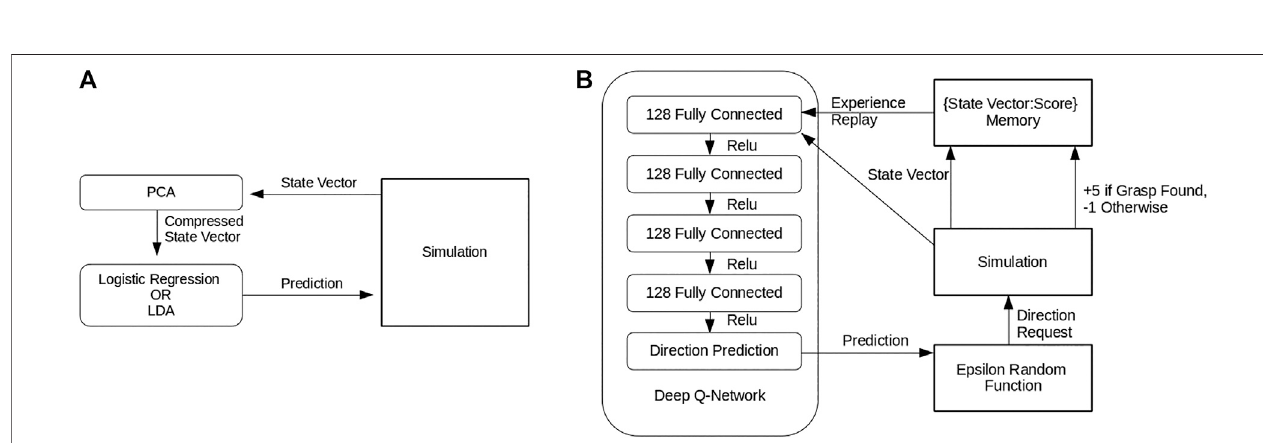
FIGURE6| Thesetofobjectsusedforsimulationtraining.Filenameslefttoright:prism6 × 6 × 6,prism10 × 8 × 4,prism20 × 6 × 5,handle,gasket,cinderblock.All dimensions are in centimeters.